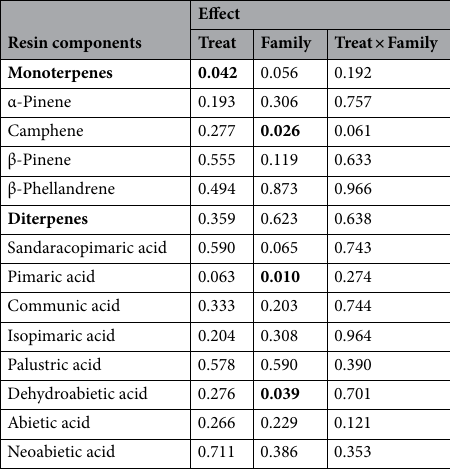
Table 2. Significance levels ( P values) from the analysis of variance conducted on the main resin components of four P. elliottii × P. caribaea families with or without resin-stimulating paste treatment. Significant effects ( P value < 0.05) are shown in bold.